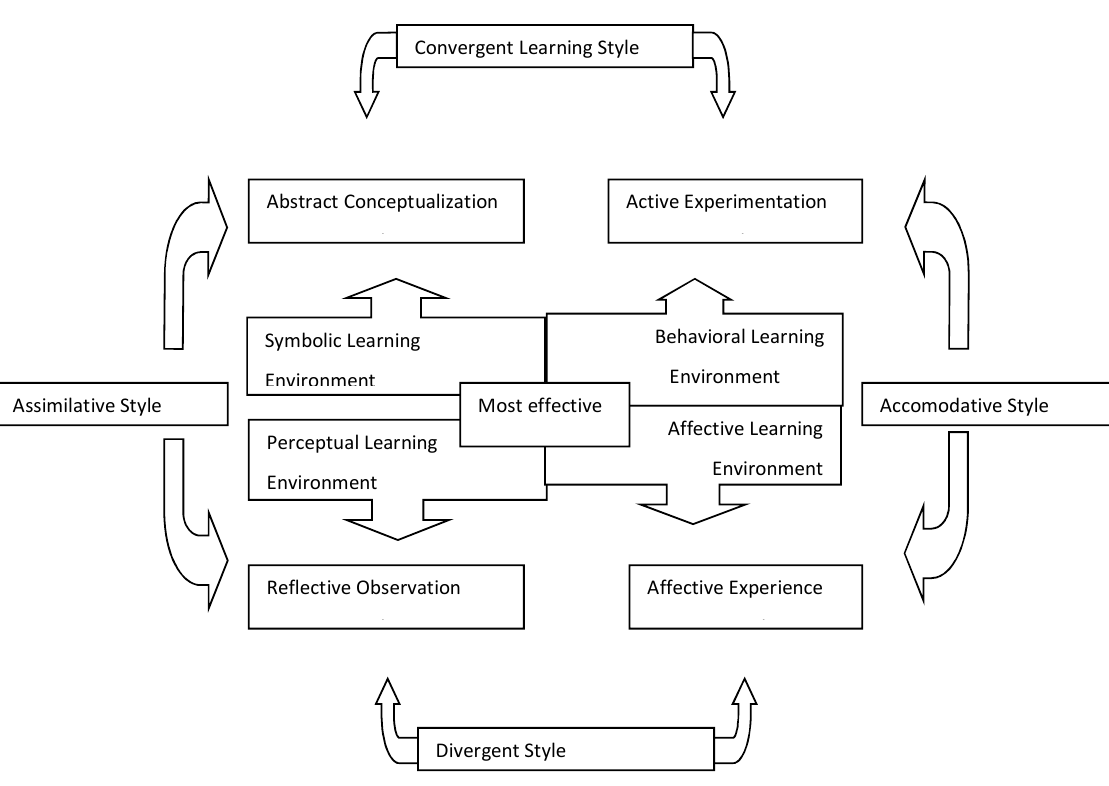
Figure 1: Conceptual Schematic of Kolb’s Learning Styles, Modes, and respective Learning Environments (Richmond, A. S., & Cummings, R., 2005, p.